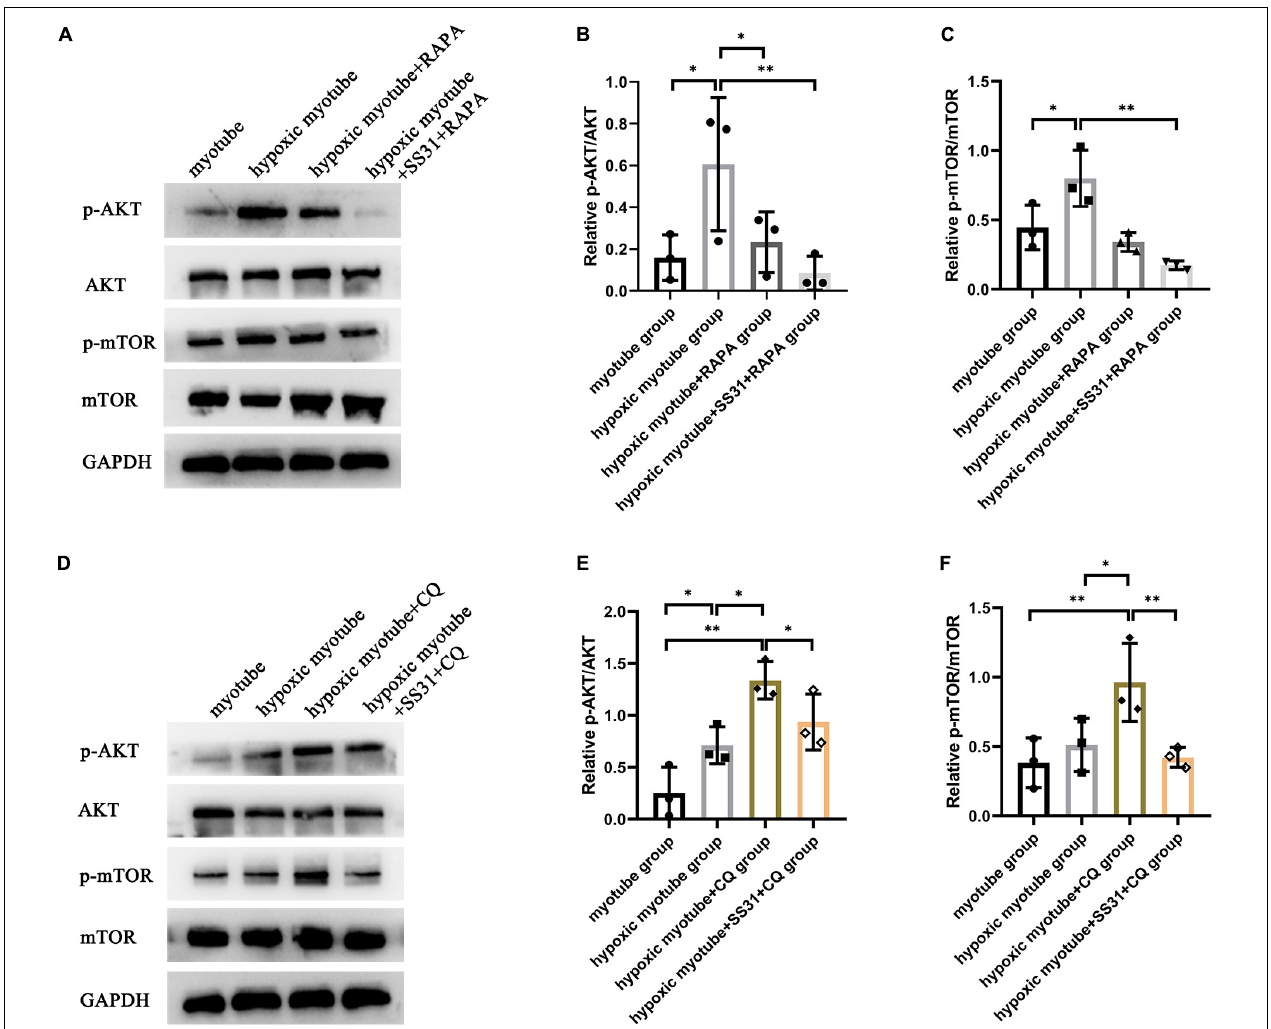
FIGURE 6 | SS31 suppresses AKT-mTOR pathway in C2C12 myotubes. (A–C) RAPA was used as the intervention in hypoxic myotubes in the presence or absence of SS31, and the levels of p-AKT and p-mTOR in C2C12 myotubes were detected. (D–F) CQ was used as the intervention in hypoxic myotubes with or without SS31 treatment. The expression levels of p-AKT and p-mTOR were examined, n = 3. ∗ p < 0.05, ∗∗ p <